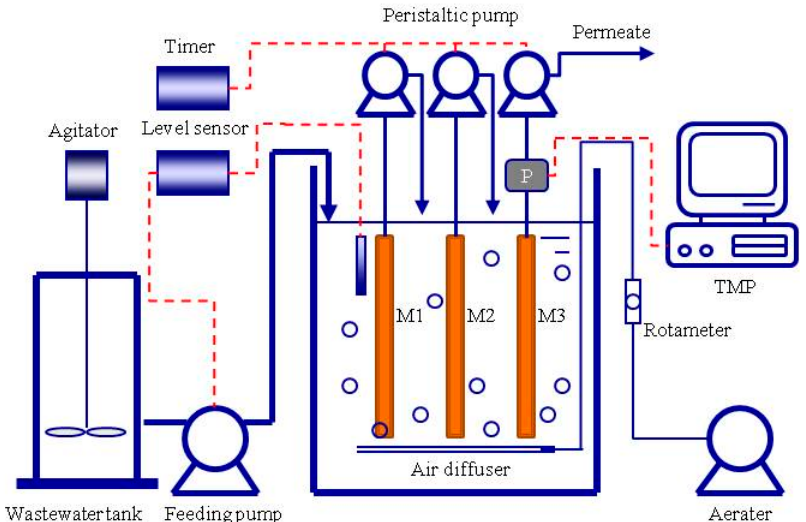
Figure 1. Schematic diagram of the membrane bioreactor (MBR) experimental setup. M1, M2, and M3 are identical membrane modules; TMP stands for transmembrane pressure; P stands for pressure